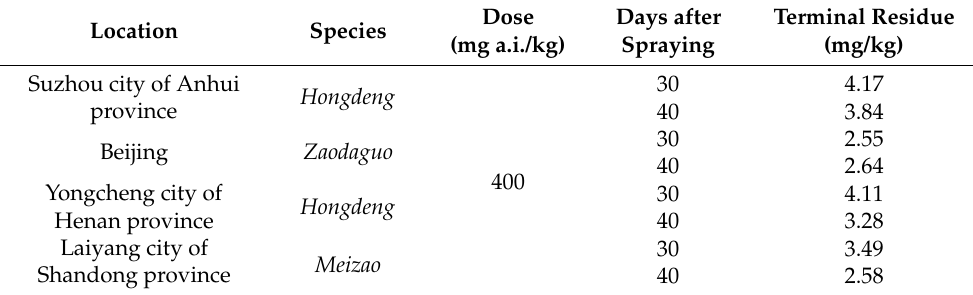
Table 5. Terminal residues of fludioxonil in cherry